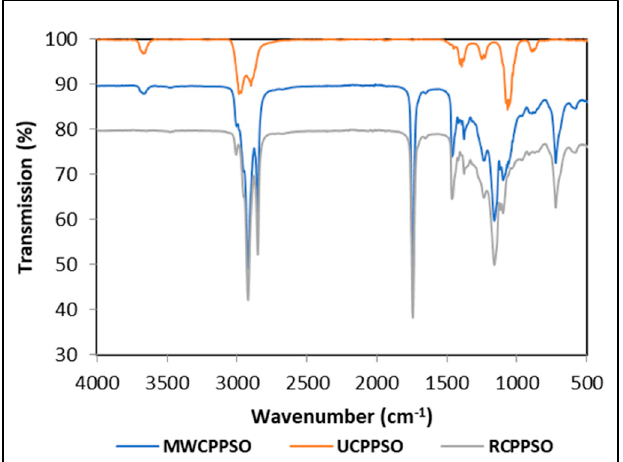
Figure 1. The FTIR spectra of